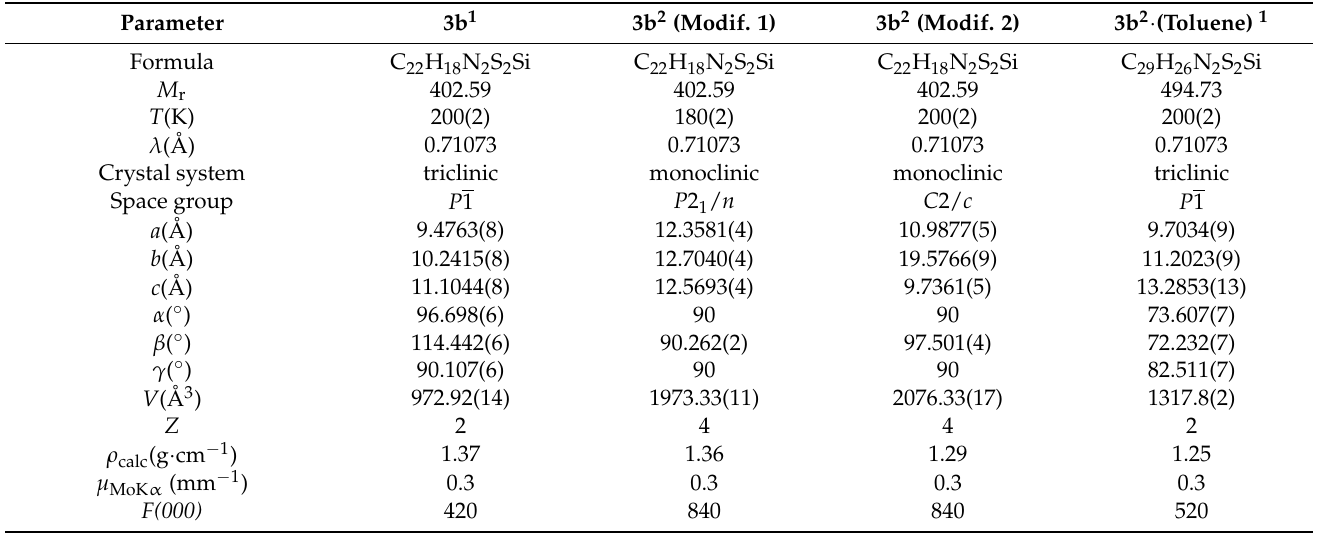
Table A2. Crystallographic data from data collection and refinement for 3b 1 , 3b 2 (two modifications) and 3b 2